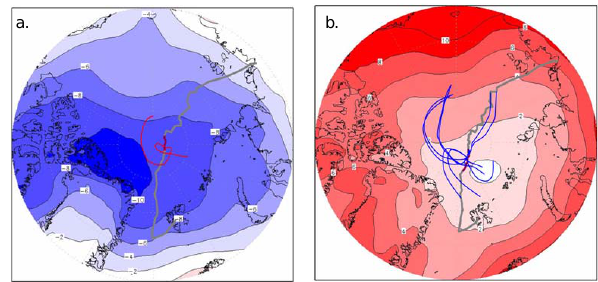
Fig. 5. The seasonal mean 925hPa temperature field in (a) April– June and (b) July–August, based on the ECMWF operational anal- yses. The 72h backward trajectories of baroclinic LLJs detected during these periods are marked by red (two cases in April–June) or blue curves (11 cases in July–August). The drift track of Tara is marked in gray with the sounding period highlighted in